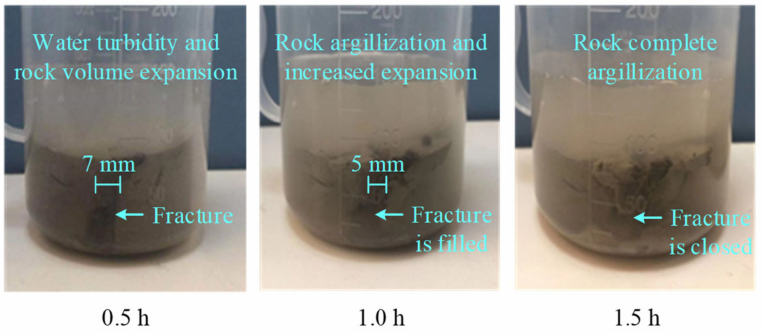
Figure 10. Water-rock interaction effect on the WCM specimen and fracture variation with